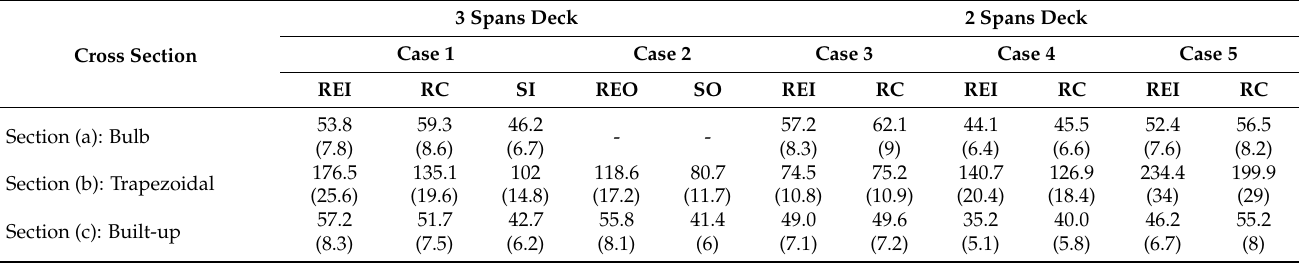
Figure 23. Von Mises stress distribution in continuum case 5. Table 4. Maximum Stresses at welded joints, MPa (ksi).